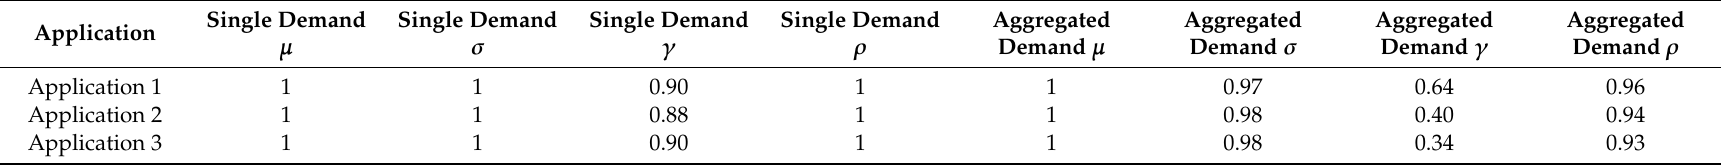
Table 3. Comparison of mean values µ , standard deviation values σ , skewness γ , rank cross-correlations ρ and ρ − lag 0 of measured and generated hourly demands, evaluating the fit in terms of R 2 at both single and aggregated scales, for each application of bottom-up procedure to Case study